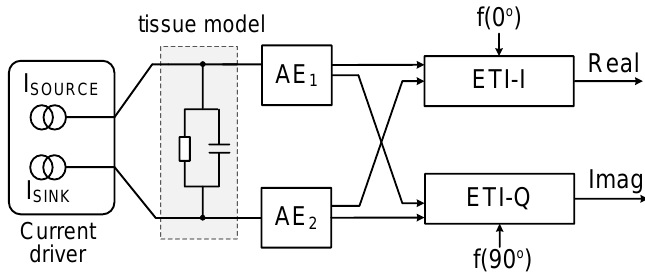
Figure 2. Schematic of electrode-tissue impedance (ETI) measurement.